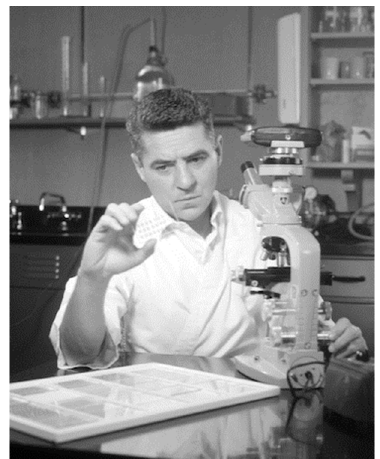
Figure 2. Leroy C. Stevens. Reproduced with permission from The Jackson Laboratory, Bar Harbor ME.